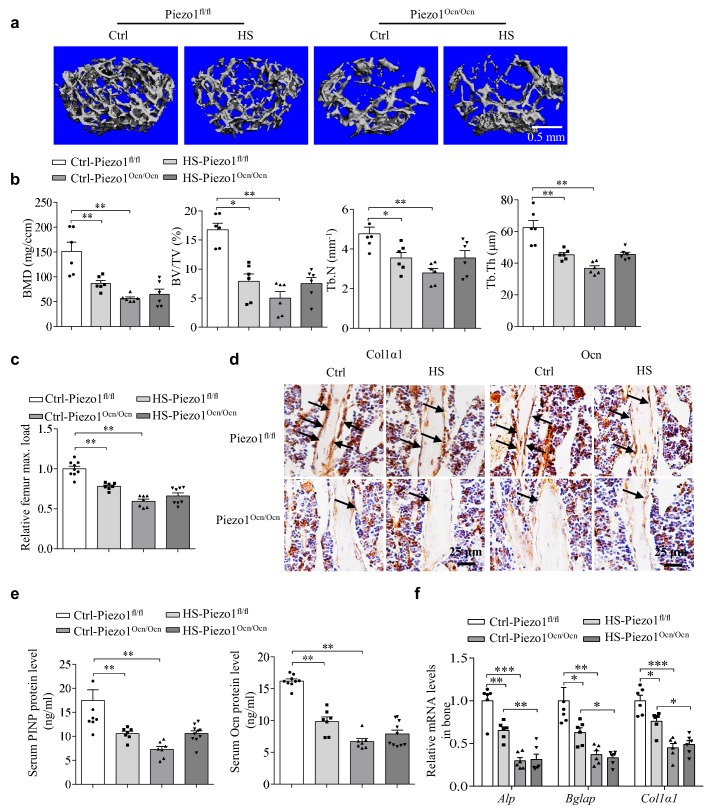
The effect of mechanical unloading on bone remodeling and osteoblast function in Piezo1fl/fl and Piezo1Ocn/Ocn mice.(a) Representative images showing three-dimensional trabecular architecture as determined by micro-CT reconstruction of the distal femurs from the groups of mice indicated. Scale bar, 0.5 mm. (b) Micro-CT measurements for BMD, BV/TV, Tb.N and Tb.Th in the distal femurs from the groups of mice indicated. n = 6 in each group. (c) Relative maximal (max.) load at failure determined by three-point bending of femurs from the groups of mice indicated. Ctrl-Piezo1fl/fl group, n = 9; HS-Piezo1fl/fl group, n = 7; Ctrl- Piezo1Ocn/Ocn group, n = 7; HS-Piezo1Ocn/Ocn group, n = 8. (d) Histology images for Col1α1 and Ocn staining of the proximal tibia from the groups of mice indicated. Scale bar: 25 μm. (e) ELISA analysis of the levels of PINP and Ocn proteins in serum from the groups of mice indicated. Ctrl- Piezo1fl/fl group, n = 9; HS-Piezo1fl/fl group, n = 7; Ctrl-Piezo1Ocn/Ocn group, n = 7; HS-Piezo1Ocn/Ocn group, n = 10. (f) QRT-PCR analysis of Alp, Bglap and Col1α1 mRNA levels in bone tissues collected from the groups of mice indicated. n = 6 in each group. All data are the mean ± s.e.m. *, p<0.05; **, p<0.01; ***, p<0.001.10.7554/eLife.47454.015Figure 4—source data 1.The data and statistical analysis of the effect of mechanical unloading on bone remodeling and osteoblast function in Piezo1fl/fl  and Piezo1Ocn/Ocn mice.